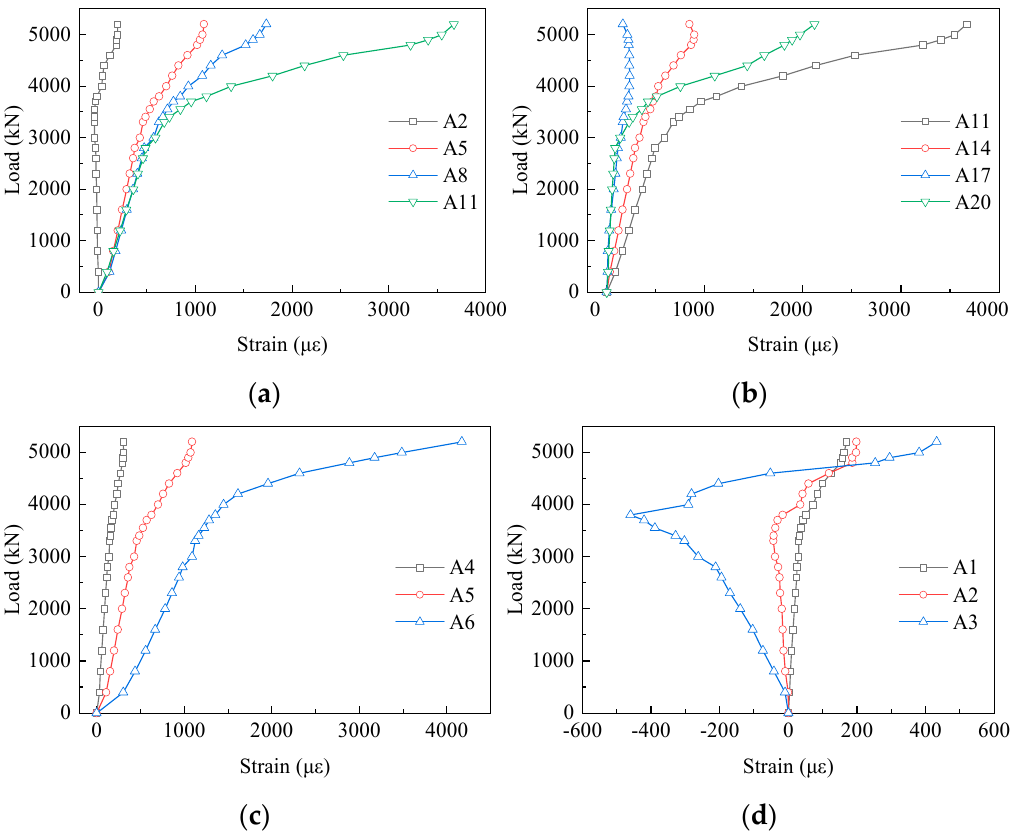
Figure 9. Load–strain curves of the embedded gusset plates: ( a ) A2 to A11 in the second row; ( b ) A11 to A20 in the second row; ( c ) the second column of strain gauges; and ( d ) the first column of the strain gauges.